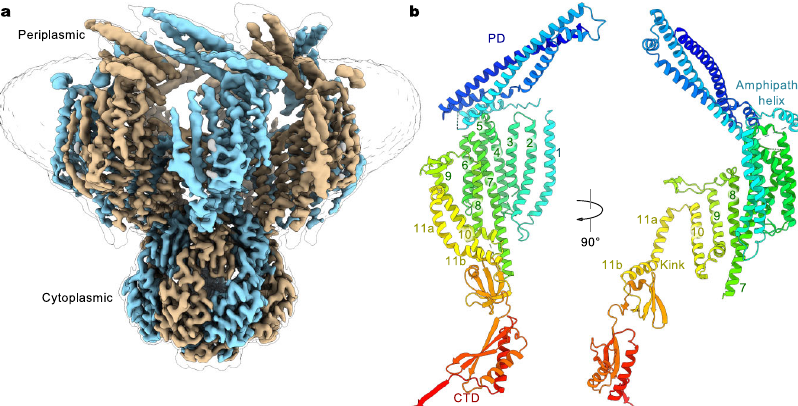
Fig. 2 | Cryo-EM structure of Ec MscK. a Cryo-EM reconstruction of Ec MscK (G924S)intheclosedstate.Detergentmicelledensitiesarealsoindicatedusingthe unsharpenedmap.Channelsubunitsareinalternatecolors. b Orthogonalviewsofa